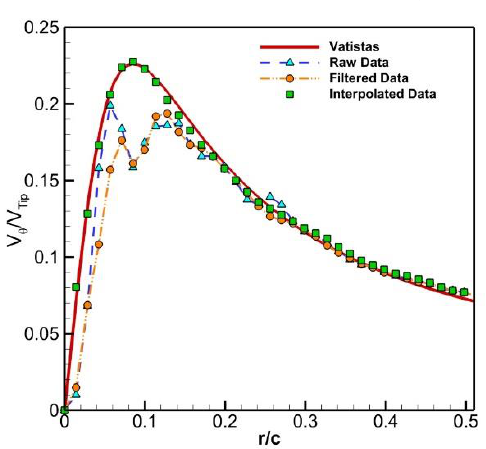
Figure 5. Vortex characteristics: swirl velocity for raw, filtered and interpolated vs. Vatistas.